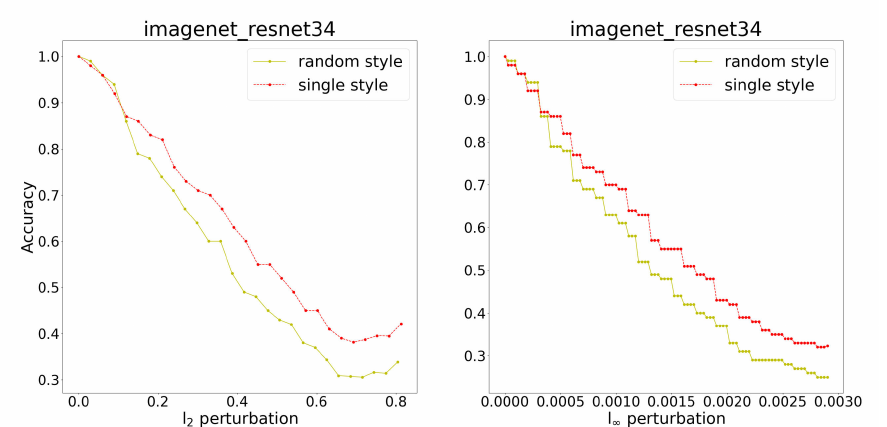
Figure 7. The adversarial accuracy rate of random style vs. single style where yellow lines denote models trained with randomly selected style images and red lines denote models trained with one single style of images. We show the perturbation strength measured by its L 2 norm ( left panel ) and L ∞ norm ( right panel